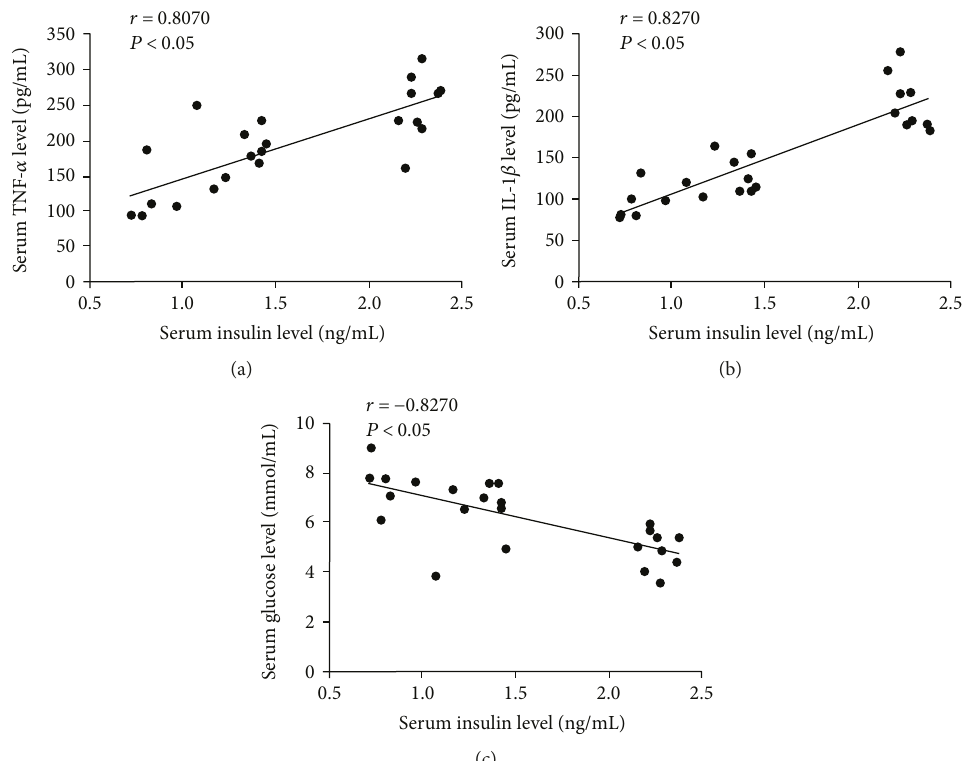
Figure 5: The correlations of serum insulin with TNF- α , IL-1 β , and glucose were analyzed using Spearman correlation test. (a) Spearman correlation between insulin and TNF- α ; (b) Spearman correlation between insulin and IL-1 β ; (c) Spearman correlation between insulin and